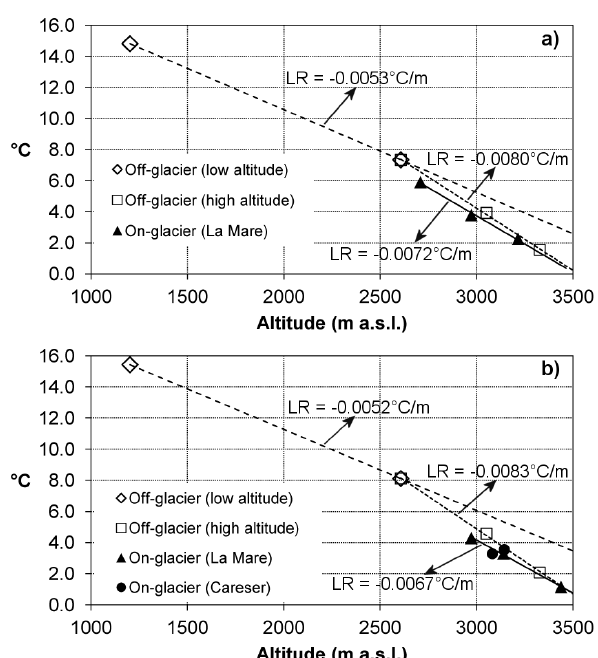
Figure 3. Mean temperature vs. altitude: (a) from 3 July to 23 September, 2010, and (b) from 7 July to 12 September, 2011. Lines indicate linear regressions of temperature vs. altitude for subsets of weather stations. LR = vertical lapse